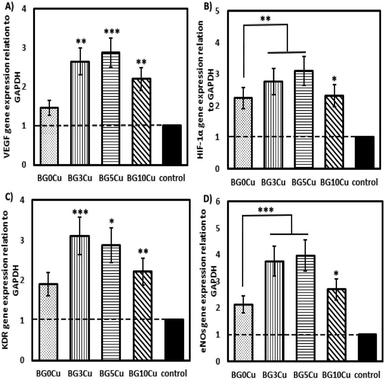
Angiogenesis-related gene expression of (A) vascular endothelial growth factor , (B) hypoxia-inducible factor-1a , (C) KDR, and (D) endothelial nitric oxidesof the human umbilical vein endothelial cells cultured in different extracts of the modified bioactive glasses (BGs) at day 7, indicating the BG3Cu and BG5Cu glasses significantly improved the angiogenesis ability in human umbilical vein endothelial cells. Data provided as mean ± standard ± deviation , n ¼ 6; all statistically significant differences fr